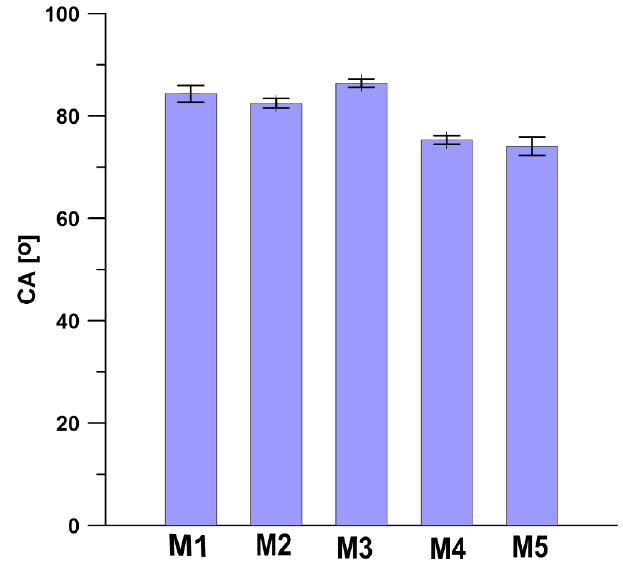
Materials 2020 , 13 , x FOR PEER REVIEW Figure 10. Water contact angle (CA) values of PPSU based membranes. Figure 10. Water contact angle (CA) values of PPSU based membranes.